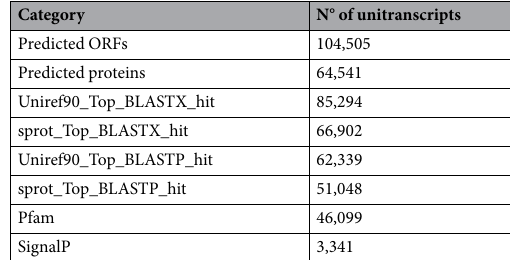
Table 2. Overview of functional annotation by homology of Capparis spinosa leaf transcriptome. ORFs, open reading frames; Uniref90_Top_BLASTX_hit, top blastx hits against UniRef90 database; sprot_Top_BLASTX_ hit, top blastx hits against UniProtKB/Swiss-Prot database; Uniref90_Top_BLASTP_hit, top blastp hits against UniRef90 database; sprot_Top_BLASTP_hit, top blastp hits against UniProtKB/Swiss-Prot database; Pfam, protein domain analysis was performed using http://www.sanger.ac.uk/software/pfam/; SignalP, the presence of signal peptides was detected using